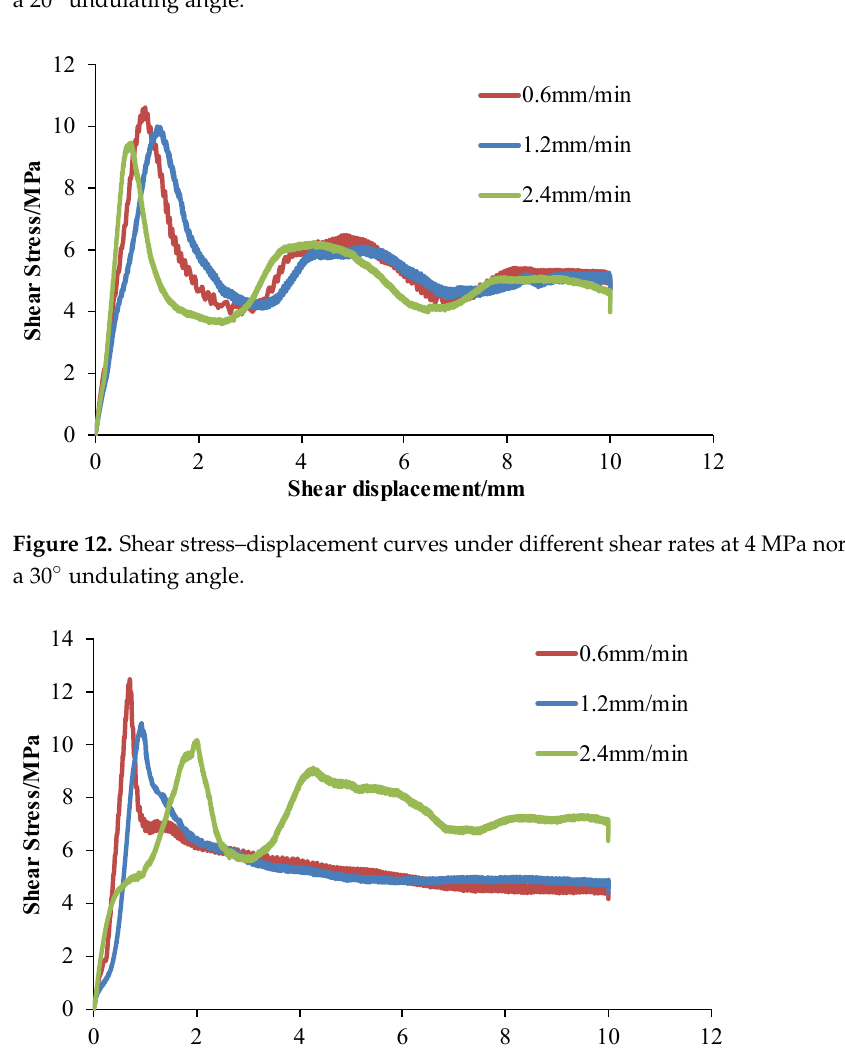
Figure 11. Shear stress–displacement curves under different shear rates at 4 MPa normal stress with a 20° undulating angle.